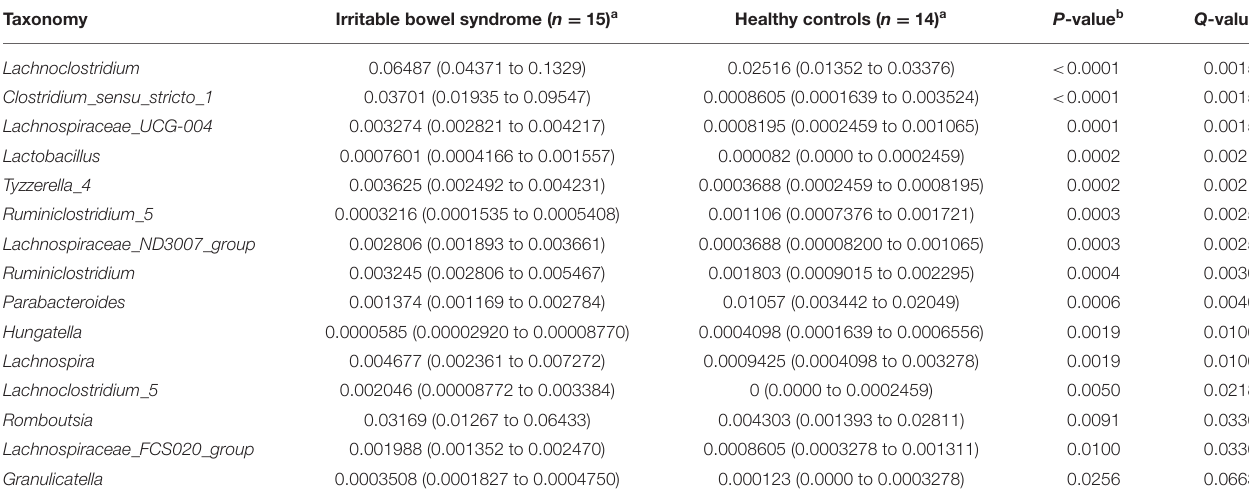
TABLE 3 | Major differentially abundant fecal microbes in IBS patients and healthy control.